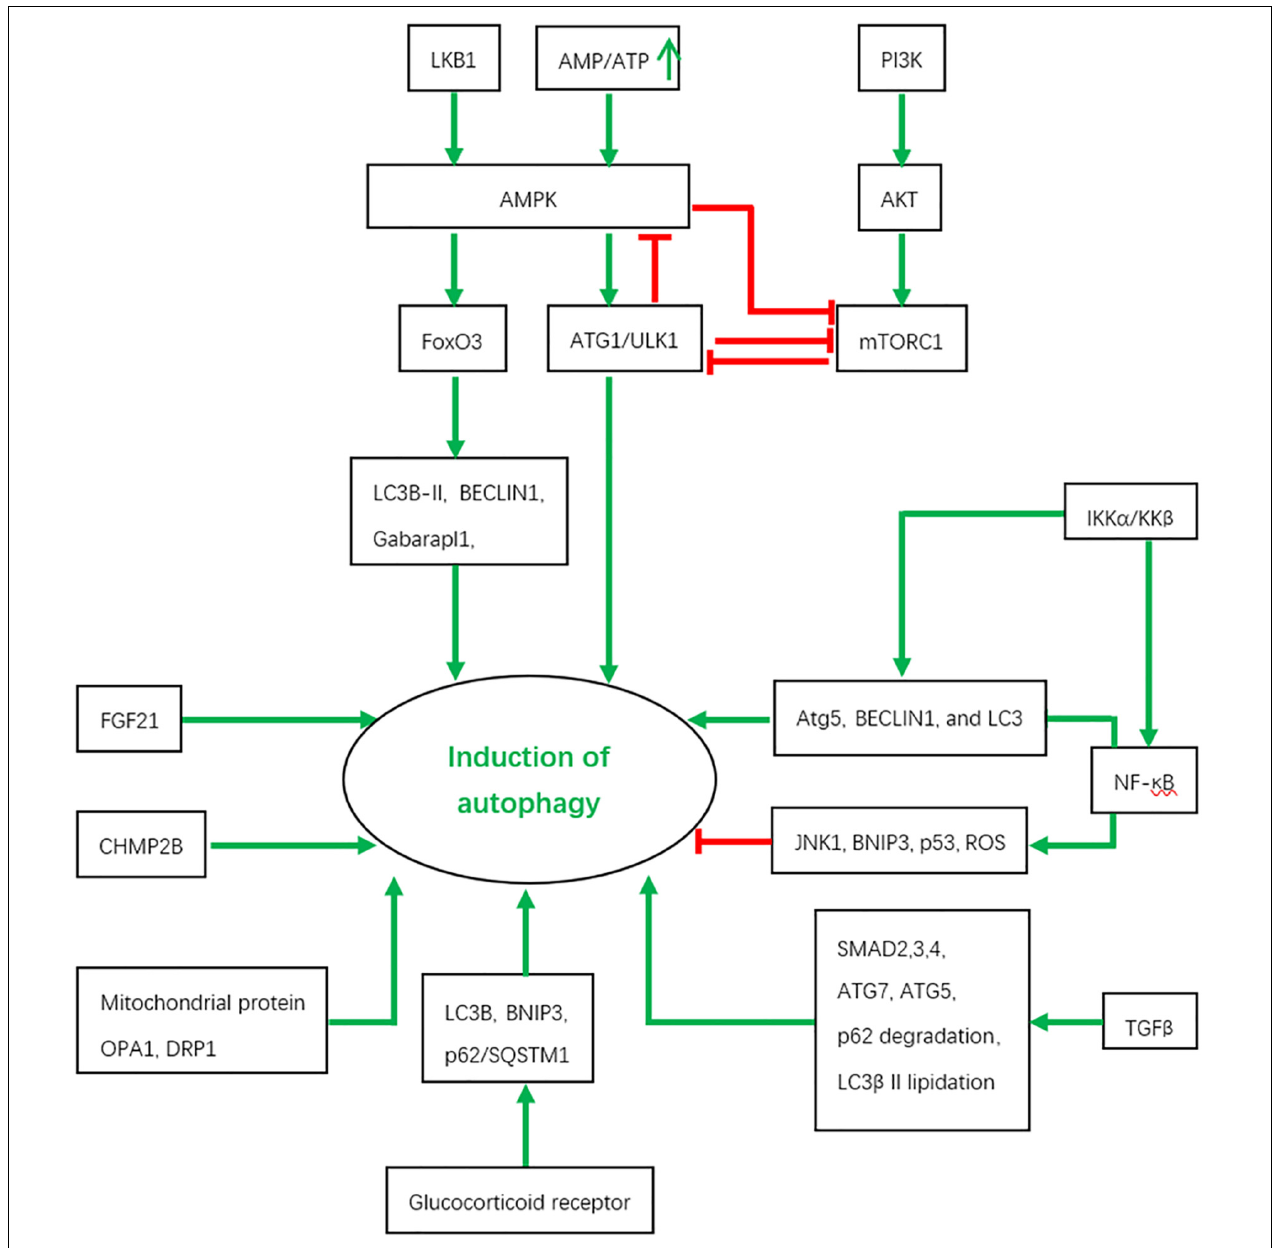
FIGURE 2 | The regulation of autophagy by various signaling pathways and the interactions between them. Red color represents inhibition and green color indicates